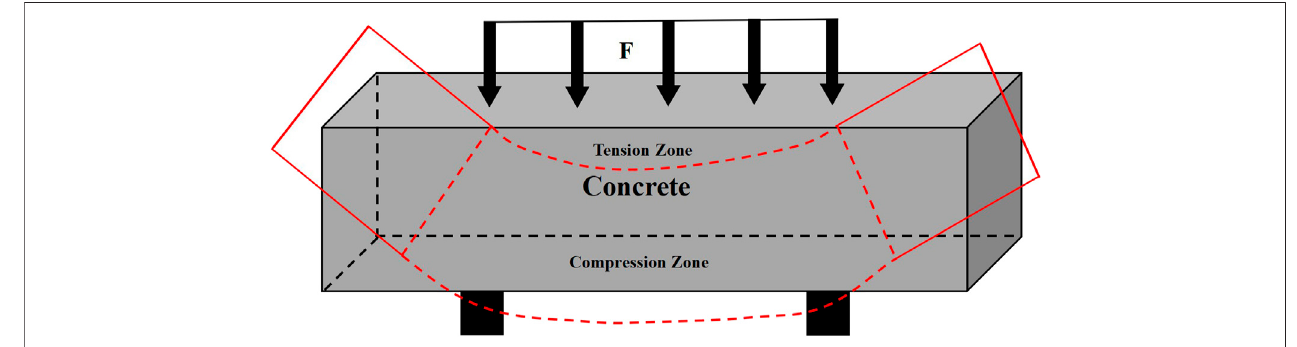
FIGURE 3 | Concrete structure under the blending